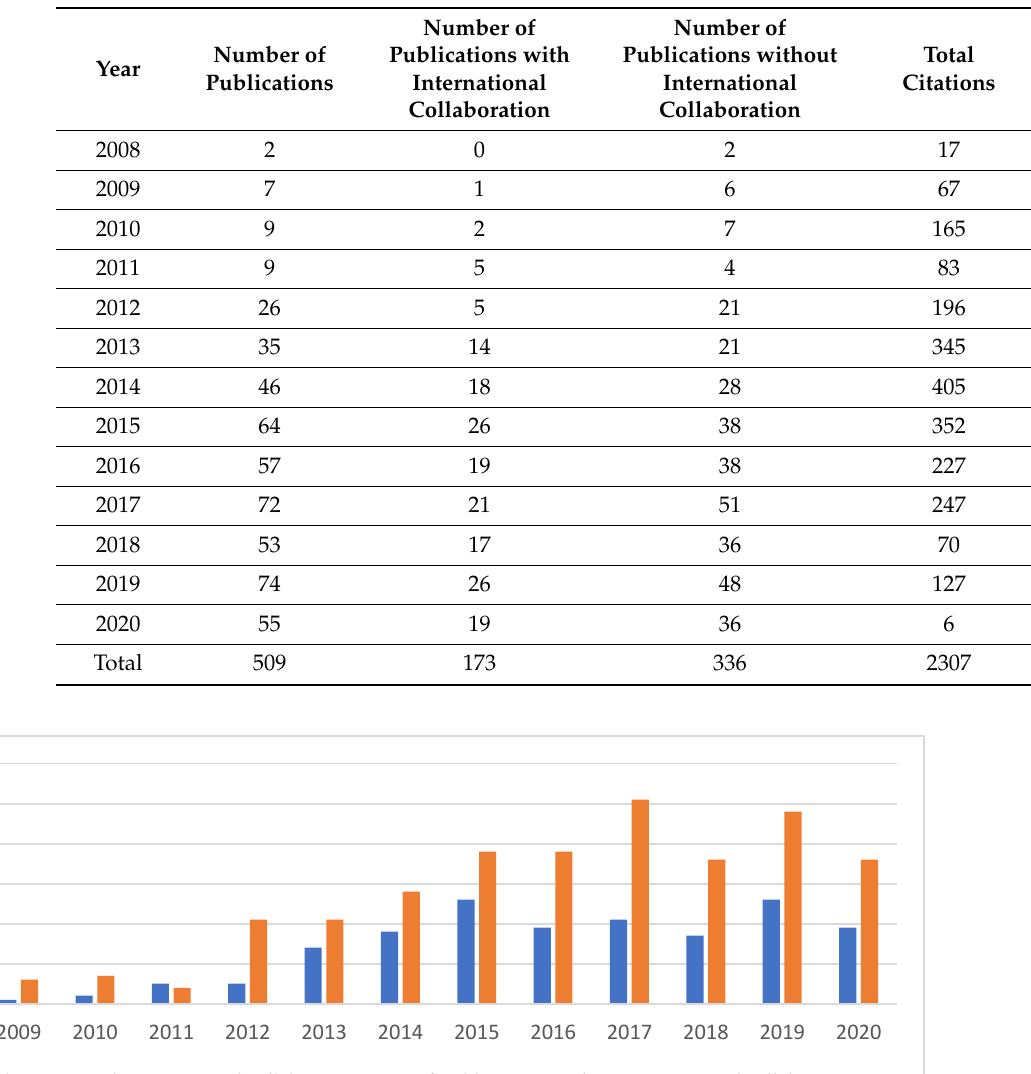
Table 3. Summary of the numbers of publications and citations from 2008 to 2020.